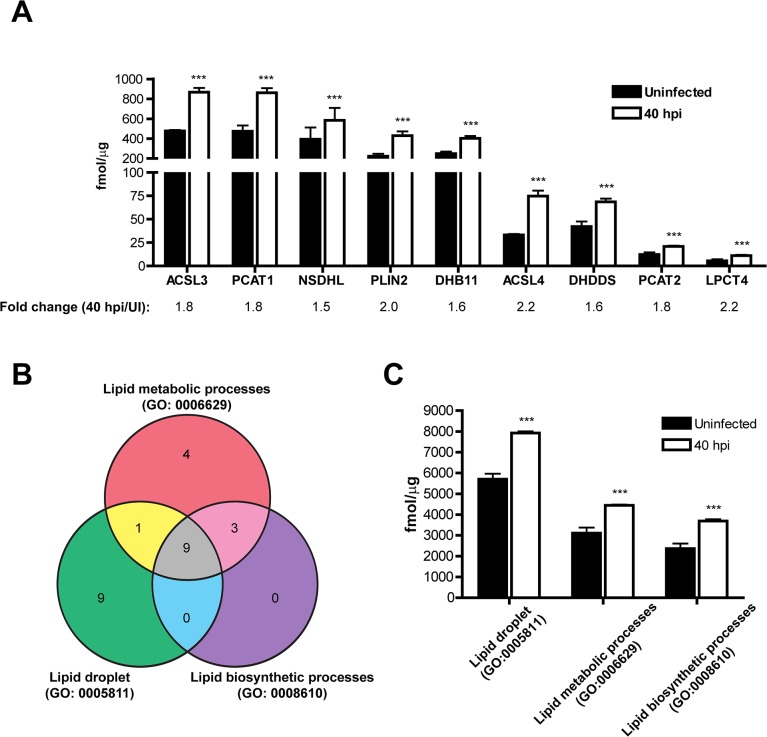
LDs isolated from C. trachomatis-infected cells are enriched in proteins related to lipid metabolism.
(A) The expression levels of all proteins belonging to “lipid metabolic processes” (GO: 0006629) increased in LD fractions at 40 hpi are represented. Bars represent the mean (fmol μg-1) resulting from six mass spectrometry-based determinations (as detailed in supporting information S3 Table). Error bars indicate the standard deviation. Asterisks (***) indicate statistically significant differences (p < 0.001, two-tailed T-test). Fold changes (40 hpi/Uninfected, average across 6 replicates) are indicated. (B) Venn diagram summarizing the overlap between the protein groups “Lipid metabolic processes” (GO: 0006629), “Lipid droplet” (GO: 0005811) and “Lipid biosynthetic processes” (GO: 0008610) identified in this study (see S5 Table for a detailed list). (C) Proteins were grouped into the indicated GO categories and the total mass for each category was calculated. Bars represent the mean (fmol μg-1) resulting from six MS-based determinations. Error bars represent the standard deviation. Asterisks (***) indicate statistically significant differences (p < 0.001, two-tailed T-test). ACSL3 (long-chain-fatty-acid-ligase 3); PCAT1 (lysophosphatidylcholine acyltransferase 1); NSDHL (sterol-4-alpha-carboxylate 3-decarboxylating); PLIN2 (perilpin-2); DHB11 (estradiol 17-beta-dehydrogenase 11); ACSL4 (long-chain-fatty-acid-ligase 4); DHDDS (dehydrodolichyl diphosphate synthase); PCAT2 (lysophosphatidylcholine acyltransferase 2); LPCT4 (lysophospholipid acyltransferase LPCAT4).